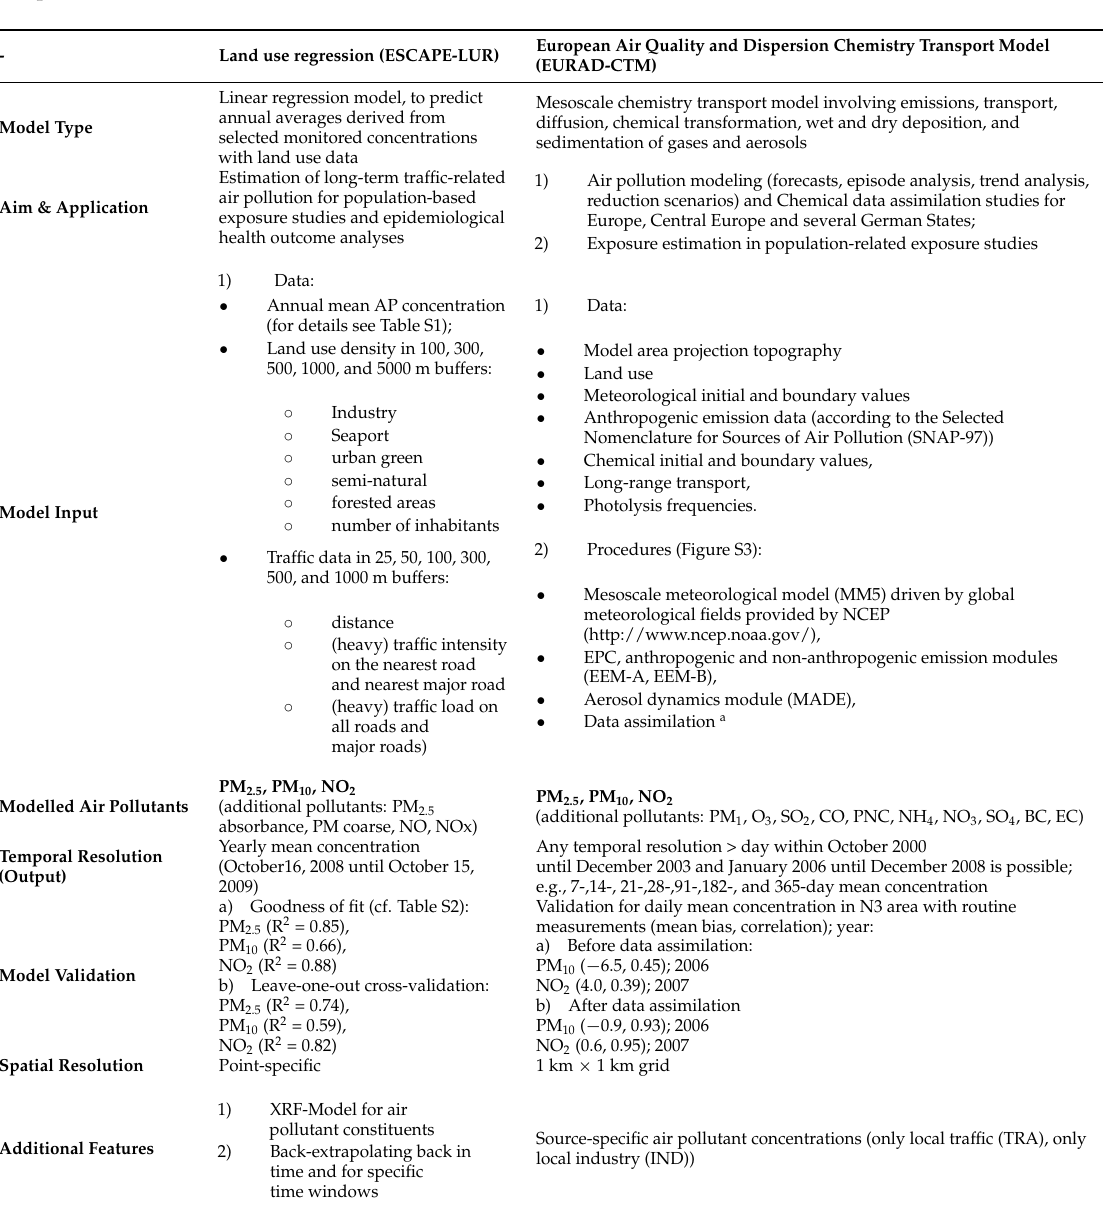
Table 1. Characteristics of the ESCAPE-LUR and EURAD-CTM approaches to estimate air pollution